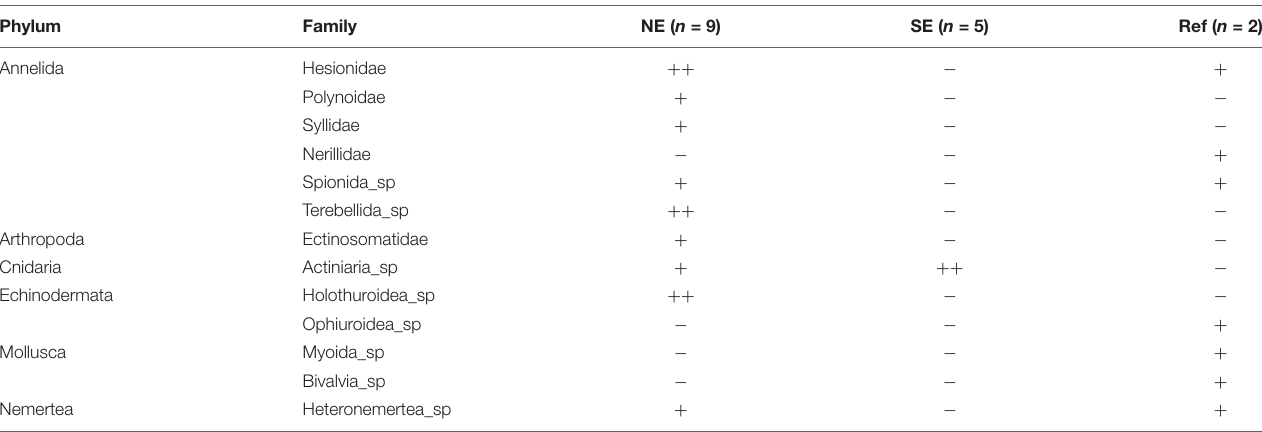
FIGURE 5 | Taxonomic composition for the three dominant phyla. For each site (NE, SE, Other, or Reference) the relative abundance of reads for the taxonomic orders is shown. TABLE 2 | The presence ( + ) or absence ( − ) of benthic taxa in the larvae